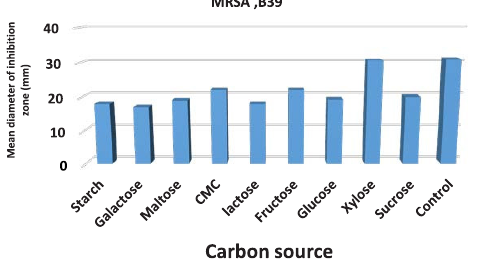
Fig. 2-c. Effect of different carbon sources on the mixture of ethyl acetate extracts of P. plebeium and E.hirta